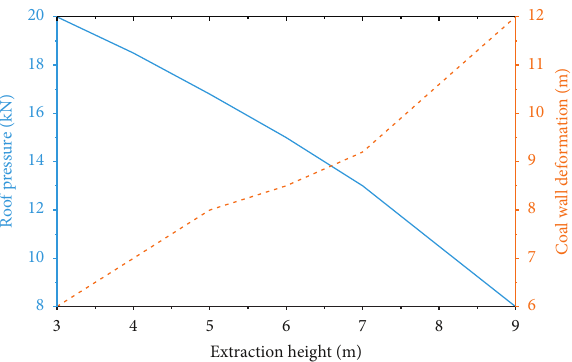
Figure 6: Variation in load-bearing capacity and displacement of the coal wall as a function of mining